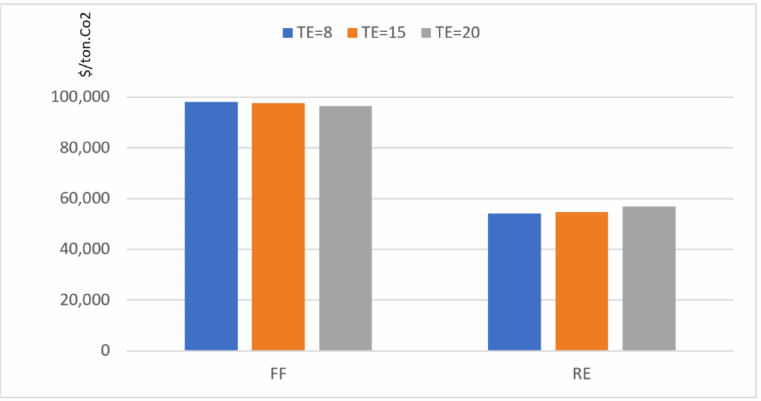
Figure 9. Sensitivity analysis of carbon tax value by fossil fuel (FF) and renewable energy (RE) power plants profit ($/ton · CO 2